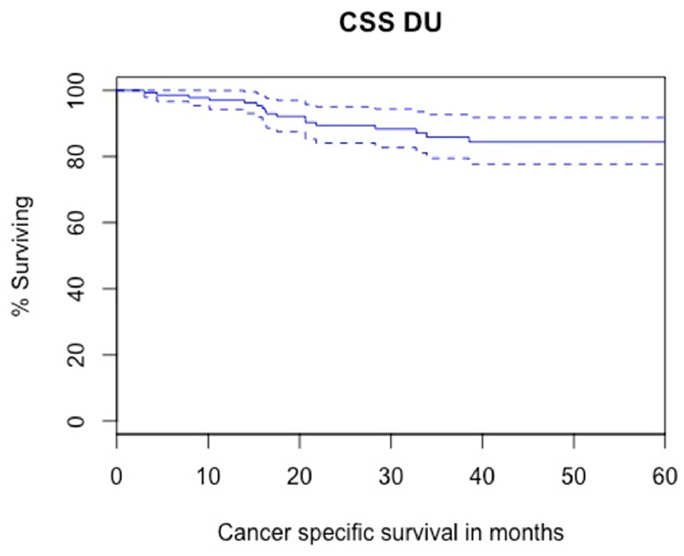
Figure 3. Kaplan–Meier modelling of cancer-specific survival (5-year CSS: 84.4%, lower—upper 95% CI